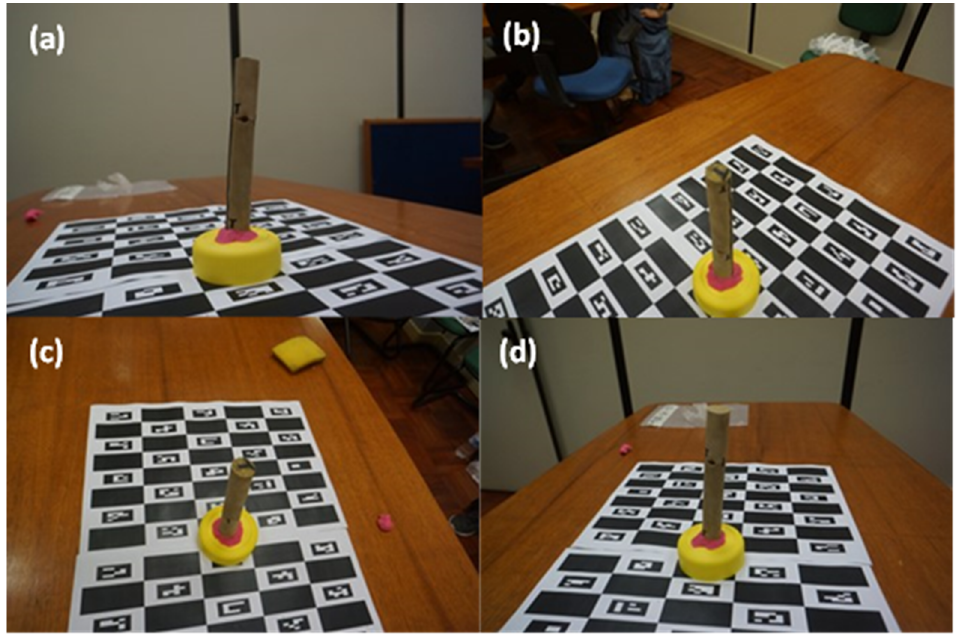
Figure 9. Photographs for the reconstruction of a 1-inch-diameter “Plug” sample. ( a ) Photo parallel to the base; ( b ) Photo at 45°; ( c ) Top photo; ( d ) Photo with the sample rotated from top to bottom and the use of modeling clay to help support the sample, as well as its differentiated pink color.